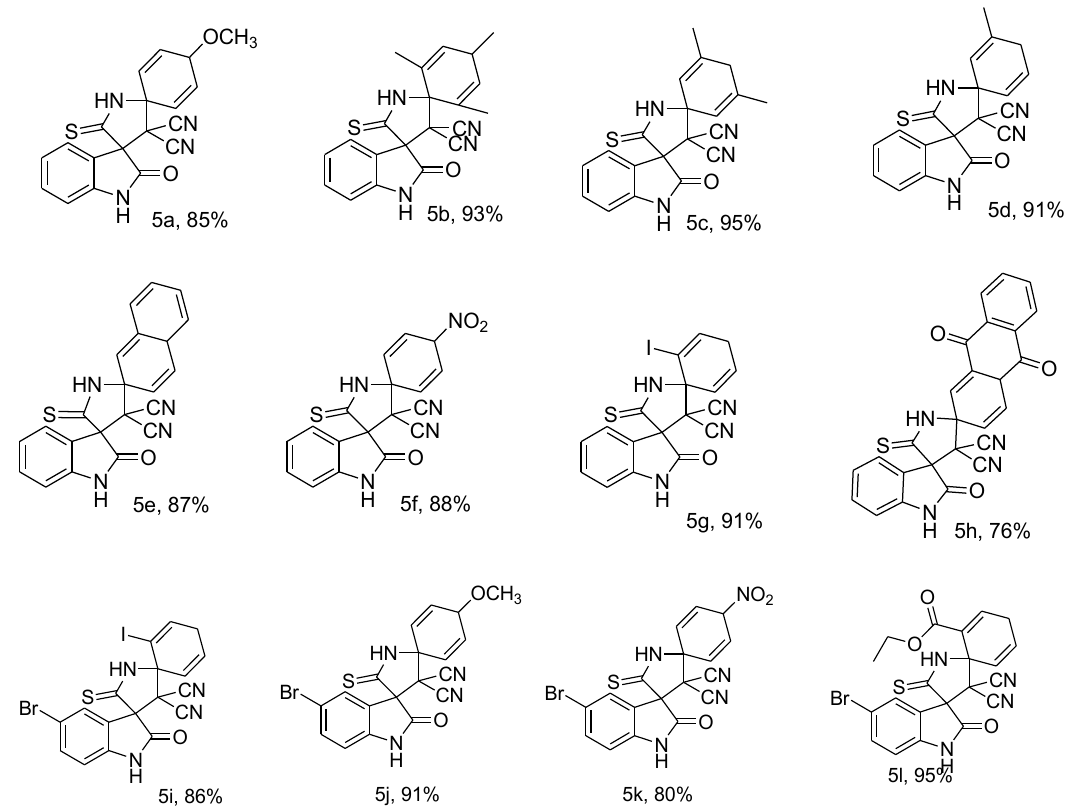
Figure 3. Variation of isothiocyanate moieties in the synthesis of spiroindoline pyrrolidine under aqua condition.